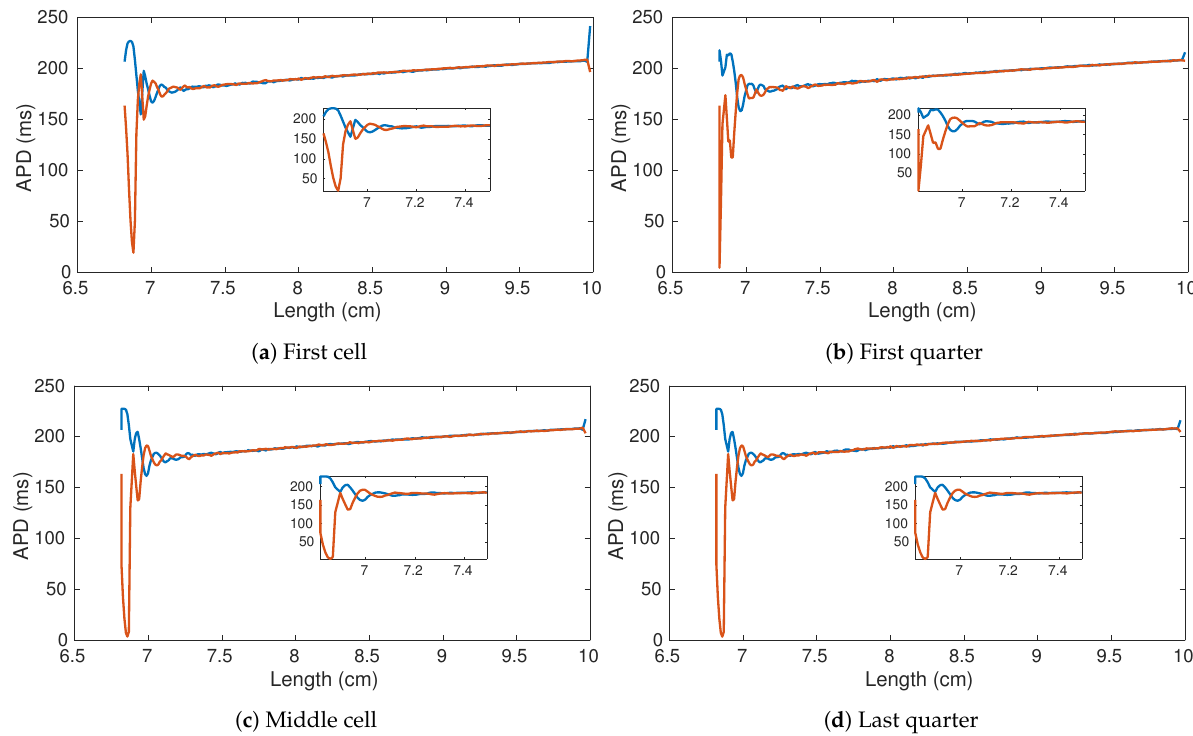
Figure 8. APD bifurication diagrams of four sampled cells within the decreasing ring experiment. The original number of cells is 1000 (10 cm). Parameters of the used von Mises distribution µ = 1.55, κ =